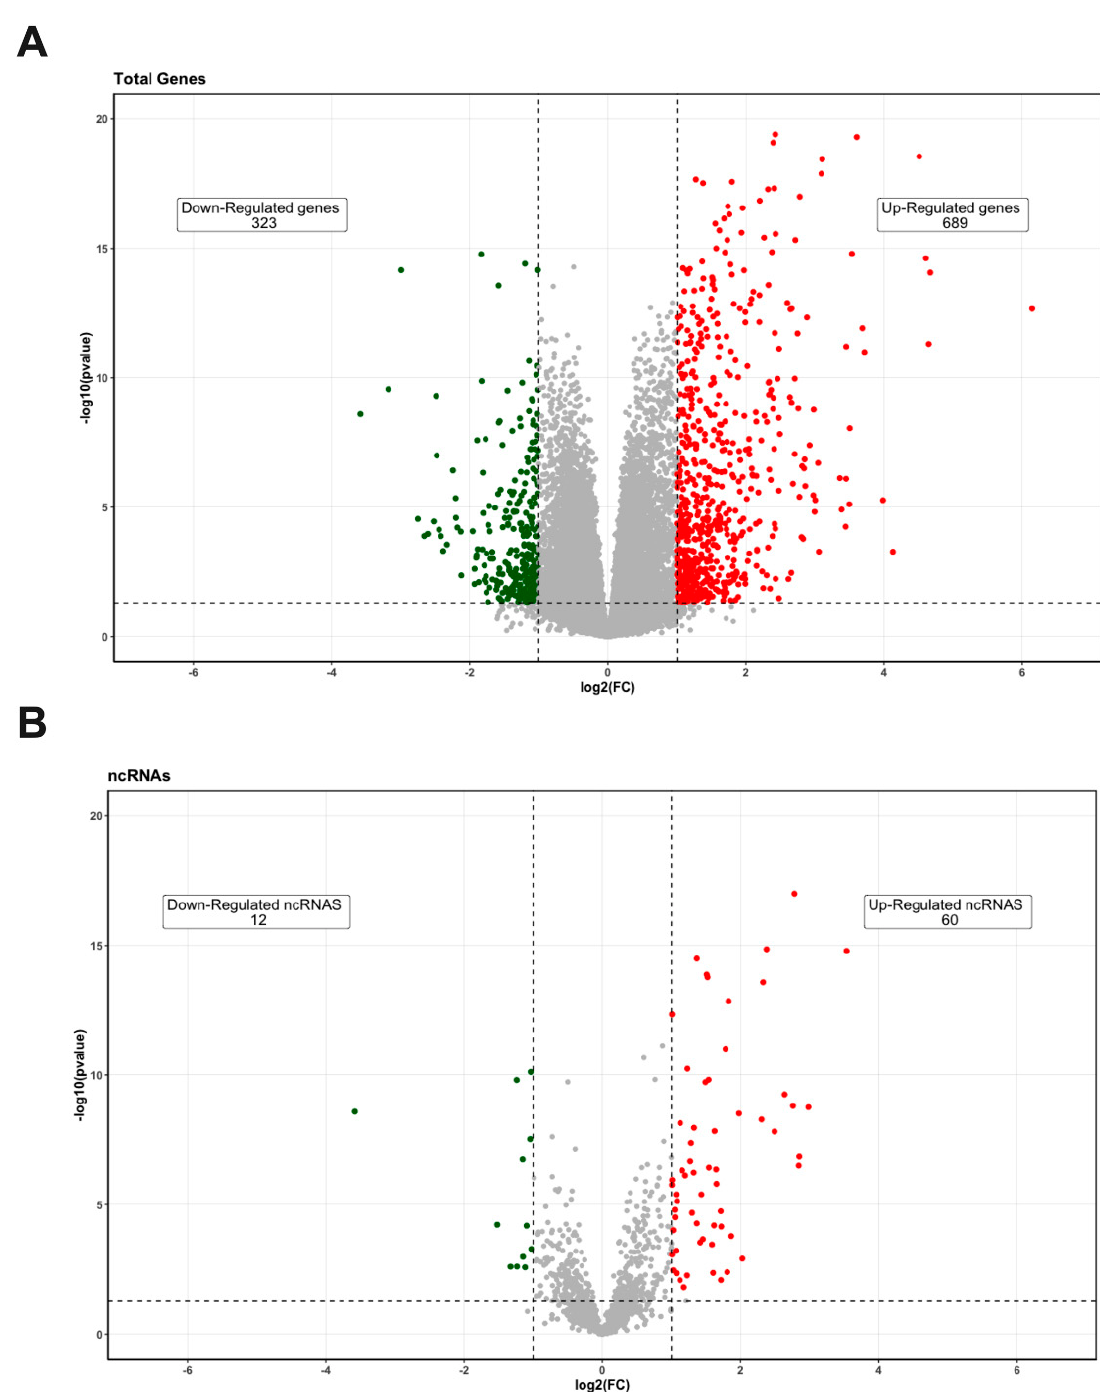
Figure 1. Differentially expressed genes in preeclampsia samples compared with normal pregnancy controls. ( A ) Volcano plot of differentially expressed genes. ( B ) Volcano plot of differentially ex- pressed ncRNAs. The vertical, dotted lines represent log2 fold change ≥ 1 or ≤− 1, and horizontal lines represent p -value < 0.05. Red and green spots represent upregulated and downregulated genes, re- spectively.